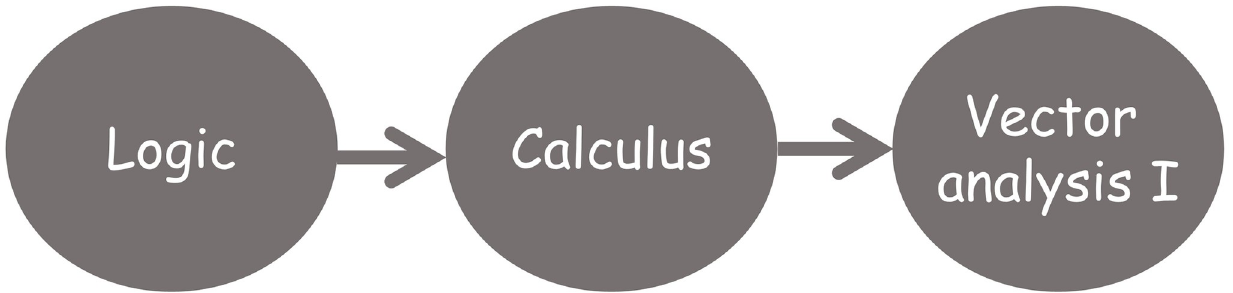
Fig 4. Example of assignment of intermediate courses in the study plan.